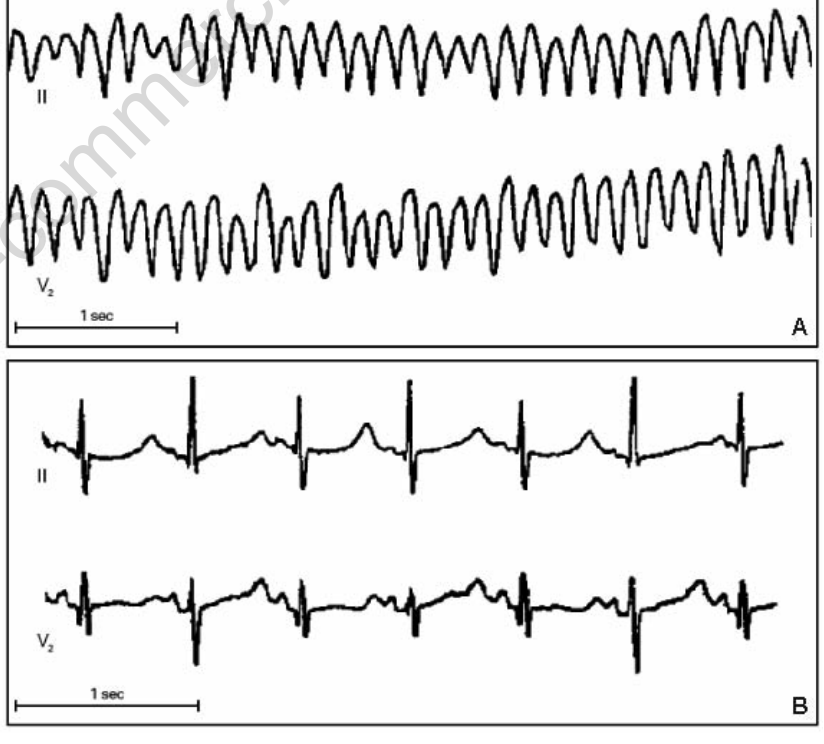
Figure 1. Electrocardiograms at the time of admission to the hospital (Panel A) and after the restoration of sinus rhythm (Panel B). At hospital admission, the 44-day-old infant had ventricular fibrillation (Panel A). After the restoration of sinus rhythm, the corrected QT interval was found to be markedly prolonged (648 ms) (Panel B), and showing clear T wave alternans. Modified from Schwartz et al.